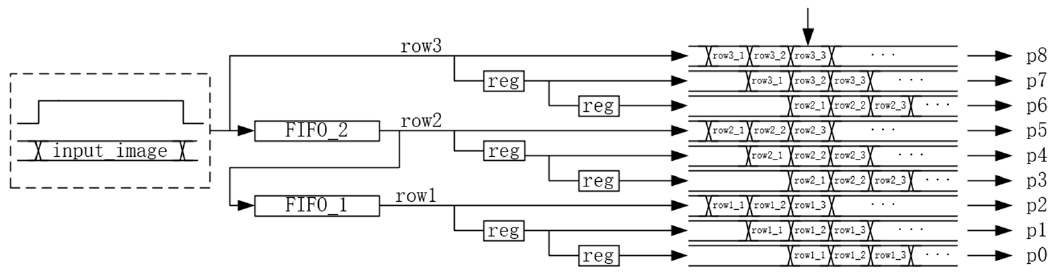
Figure 4. Architecture of Line Buffer.